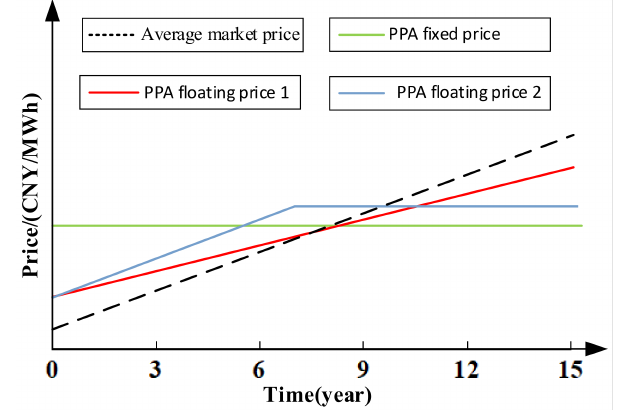
Figure 2. Schematic diagram of PPA contract